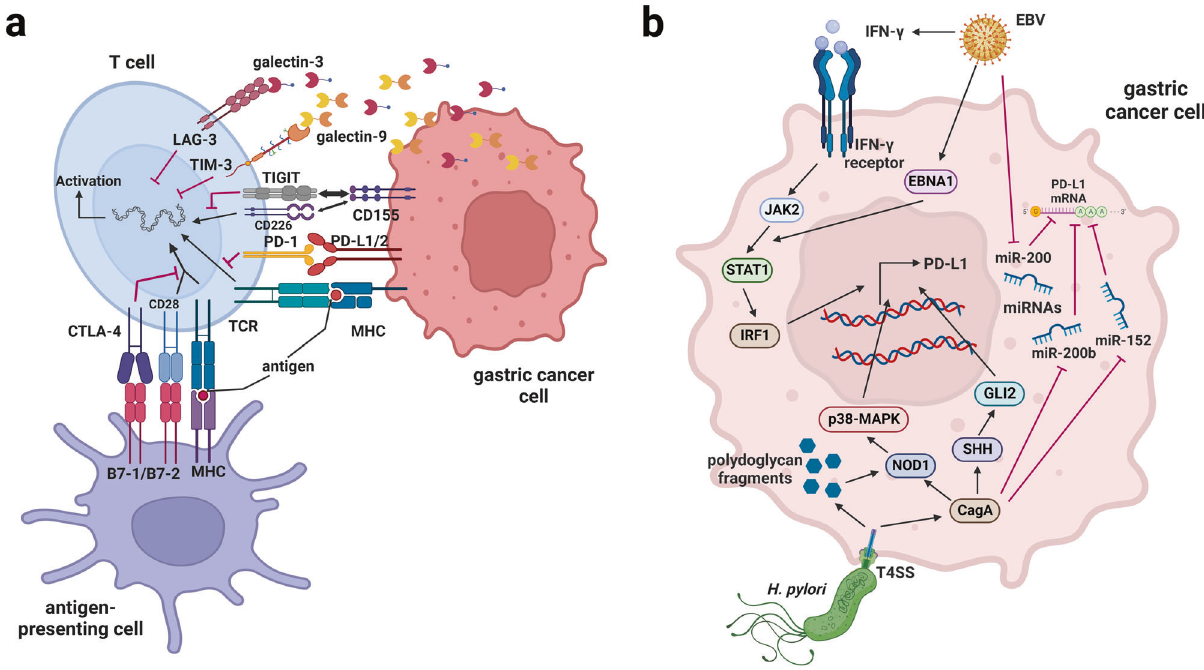
Fig. 3 The immune checkpoint signaling pathways in gastric cancer and regulations on PD-L1 by H. pylori and EBV. a The immune checkpoint proteins PD-1 on the surface of T cells interact with the ligands PD-L1/PD-L2 on GC cells, or the aberrant CTLA-4 proteins on GC patient T cells interact with B7 on antigen-presenting cells, resulting in an immunosuppressive microenvironment, providing cancer cells with a survival advantage. TIGIT on the T cells membrane competes with the activation of CD226 binding to CD155 from the GC cells. Other immune checkpoint proteins, TIM-3 or LAG-3, interact with galectin-9 or galectin-3 released from GC cells, inhibiting the activation of T cells. b Chronic H. pylori or EBV infection, which are risk factors of GC, can induce upregulation of PD-L1 in GC cells via various signaling pathways and microRNAs, promoting immune escape. EBV Epstein – Barr virus, PD-1 programmed death 1, PD-L1/2 programmed death ligand 1/2, CTLA-4 cytotoxic T-lymphocyte-associated protein 4, TCR T-cell receptor, MHC major histocompatibility complex, TIGIT T cell immunoreceptor with Ig and ITIM domains, TIM-3 T cell immunoglobulin and mucin-domain containing-3, LAG-3 lymphocyte-activation gene 3, IFN- γ interferon gamma, JAK2 Janus kinase 2, STAT1 signal transducer and activator of transcription 1, IRF1 interferon regulatory factor 1, EBNA1 Epstein – Barr nuclear antigen 1, MAPK mitogen-activated protein kinase, NOD1 nucleotide-binding oligomerization domain-containing protein 1, SHH Sonic hedgehog protein, CagA cytotoxin-associated gene A, T4SS type IV secretion system. This fi gure was created with